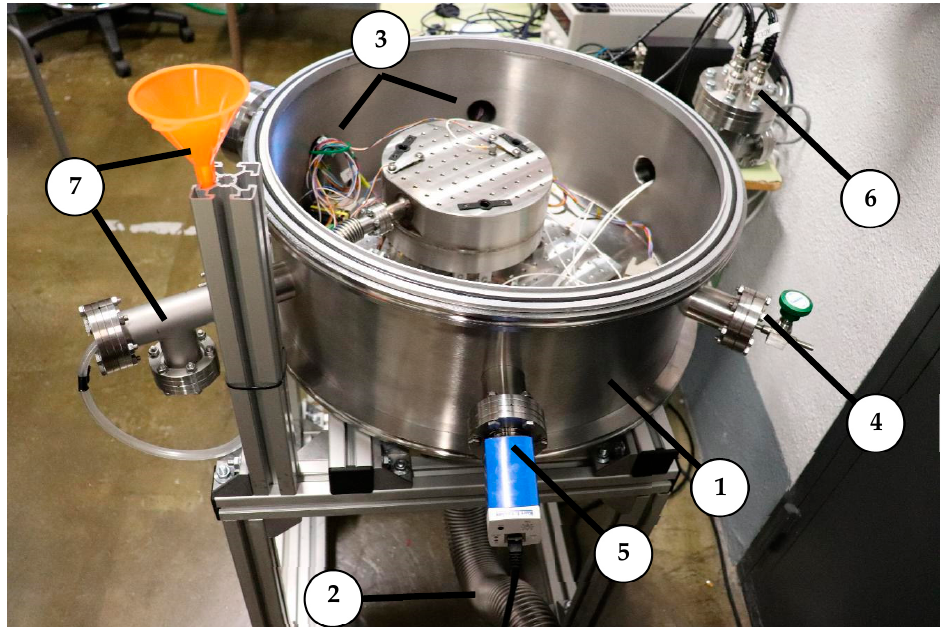
Figure 16. The cold plate inside the vacuum chamber: ( 1 ) Vacuum chamber, ( 2 ) pumping station bellow, ( 3 ) electrical pin ports, ( 4 ) manual vent, ( 5 ) pressure gauge, ( 6 ) BNC coaxial wire port, ( 7 ) LN 2 supply.